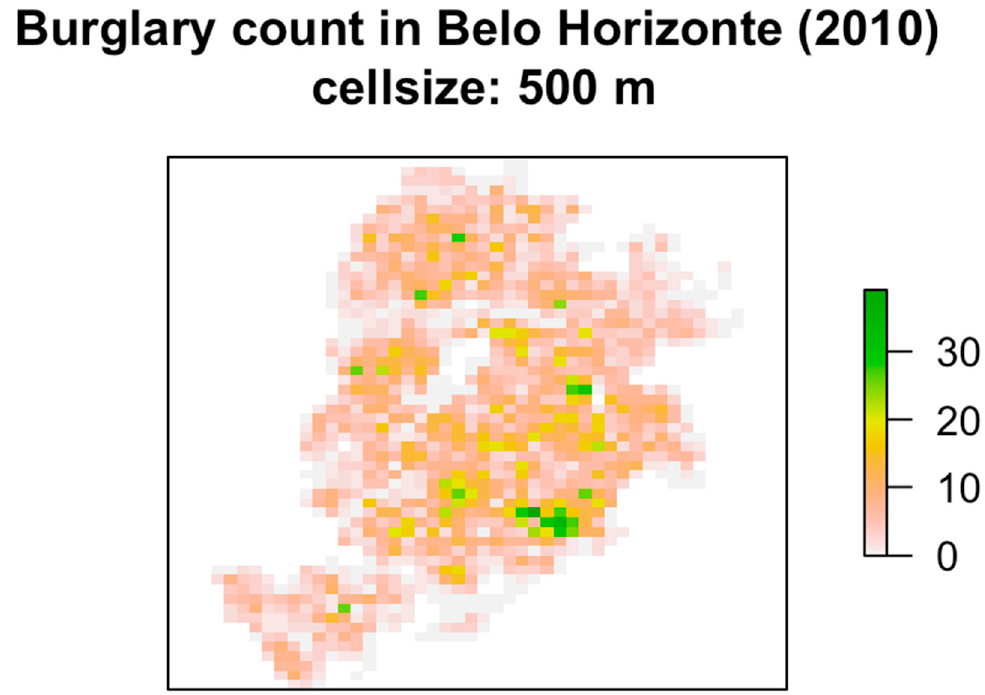
Figure 3. Burglary count for Belo Horizonte in 2010. Cell size used was 500 meters.